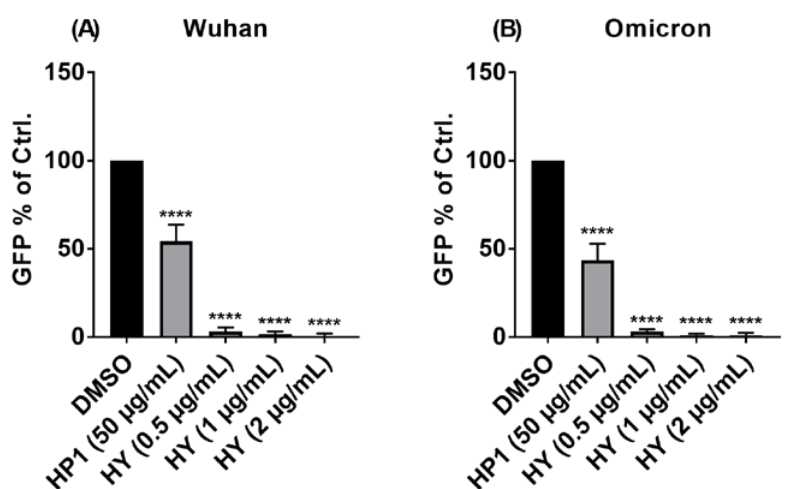
Figure 7. Hypericum perforatum (HP1) and its ingredient hypericin (HY) showed an antiviral capacity against the pseudotyped VSV virus carrying SARS-CoV-2 S protein of the Omicron variant. Vero cells were seeded overnight, and the day after, cells were treated for 1 h at 37 ◦ C with fresh DMEM-10% FCS containing the solvent control (DMSO) or the indicated concentration of HP1 or hypericin. In parallel, the pseudo-typed virus carrying ( A ) the genuine SARS-CoV-2 S protein (Wuhan S protein sequence) or ( B ) the Omicron variant S protein (Omicron S protein sequence) was incubated with either solvent control or the indicated concentration of each substance at room temperature for 1 h. After the 1 h incubation, the virus solution (MOI = 0.01) was applied on cells for 1 h, at 37 ◦ C for infection, followed by a DMEM-10% FCS wash step, and a final application of fresh DMEM-10 % FCS. On the next day, GFP-positive cells were counted by Celigo Image Cytometer (Nexcelom Bioscience, Lawrence, MA, USA). GFP-positive cells as % of control are shown (mean and s.d.), and one-way ANOVA with Dunnett’s multiple comparisons was done by comparing each value with the control. **** for p ≤ 0.0001.